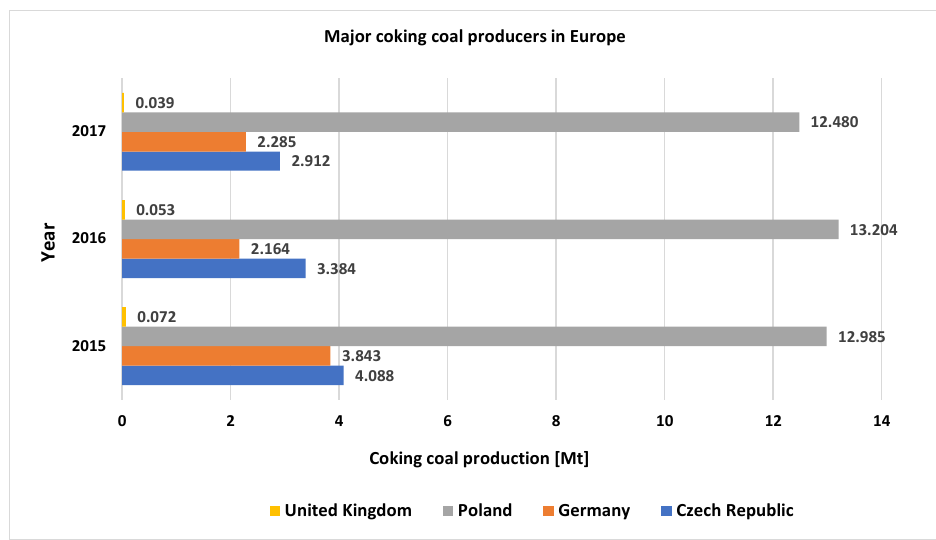
Figure 1. Major coking coal producers in Europe [9].